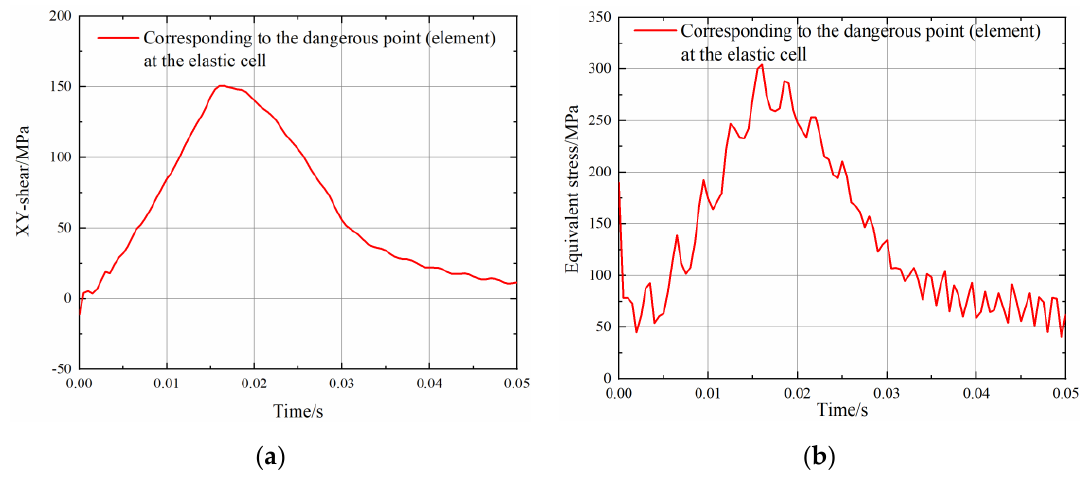
Figure 16. Stress time-history response of sensing area under impact load: ( a ) torsional shear stress ( b ) Mises stress.